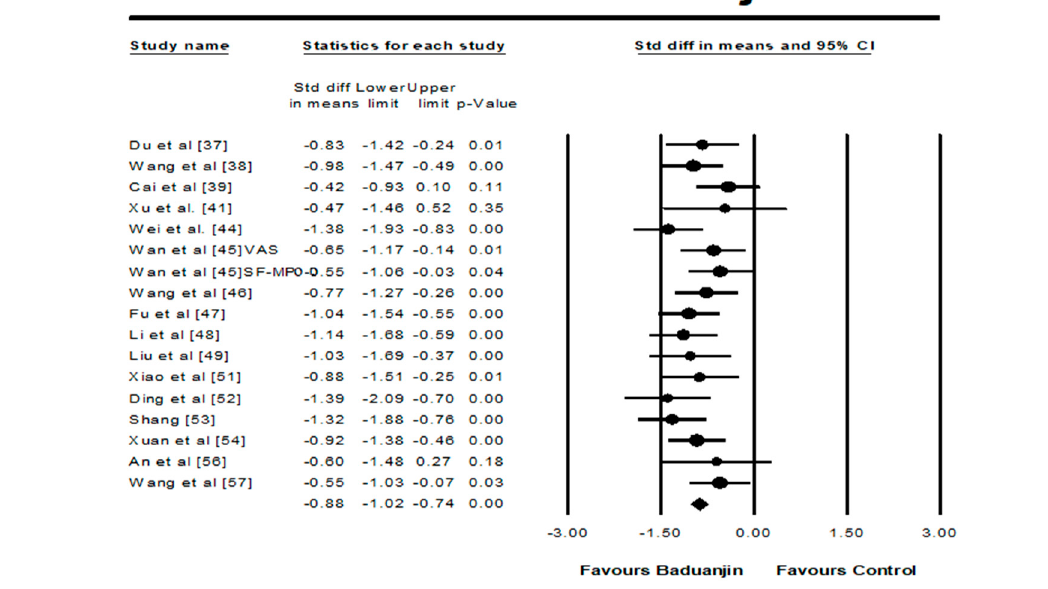
Figure 2. Effect of Baduanjin on musculoskeletal pain (Condition 1).